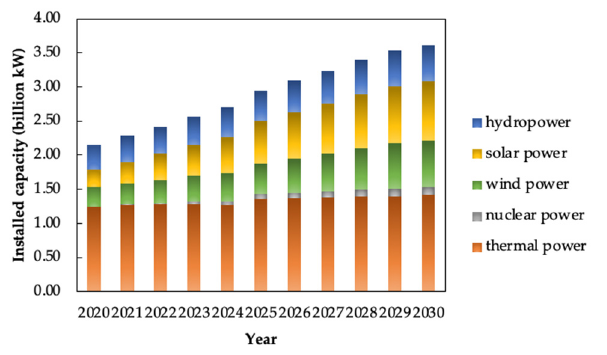
Figure 6. Installed capacity of various energy sources under the extreme weather condition.